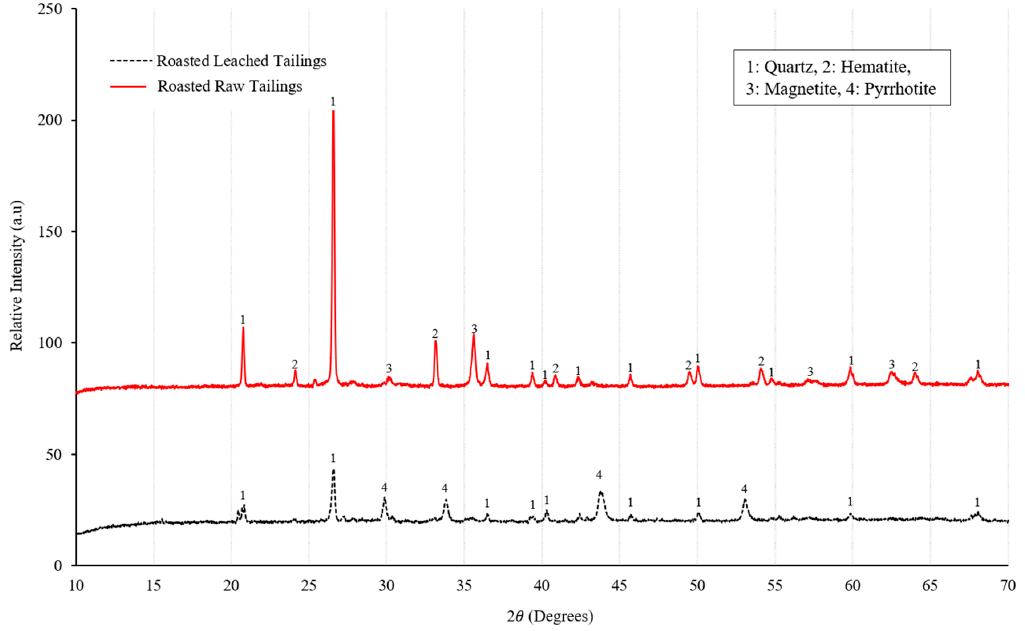
Figure 2. XRD results of roasted tailings specimens.